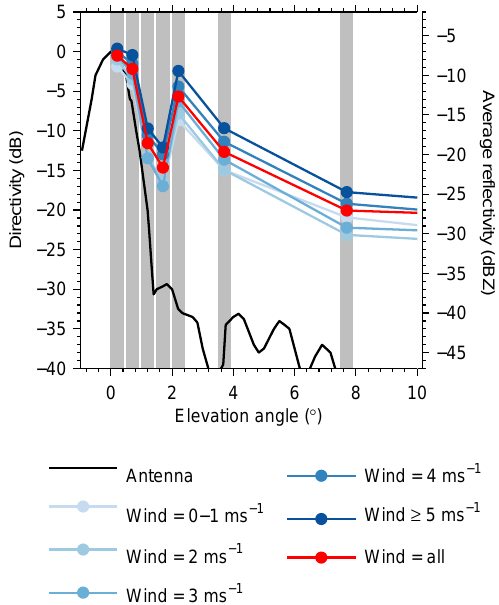
Figure 11. Increase in average reflectivity, (cid:104) Z (cid:105) , from radar cells in and below which three wind turbines are located for different tilt angles and wind speeds. The wind speed measurements come from an automatic weather station, located approximately 21km to the west of the weather radar. The black solid line shows a vertical cut of the antenna pattern. The grey areas show the angular extent of the wind turbine blades for the different tilt